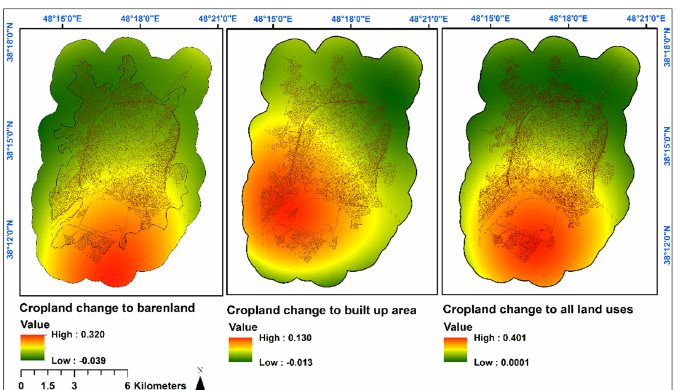
Figure 7. The trend of croplands to be changed to other land-use types (bare lands, built-up areas, and all land uses).